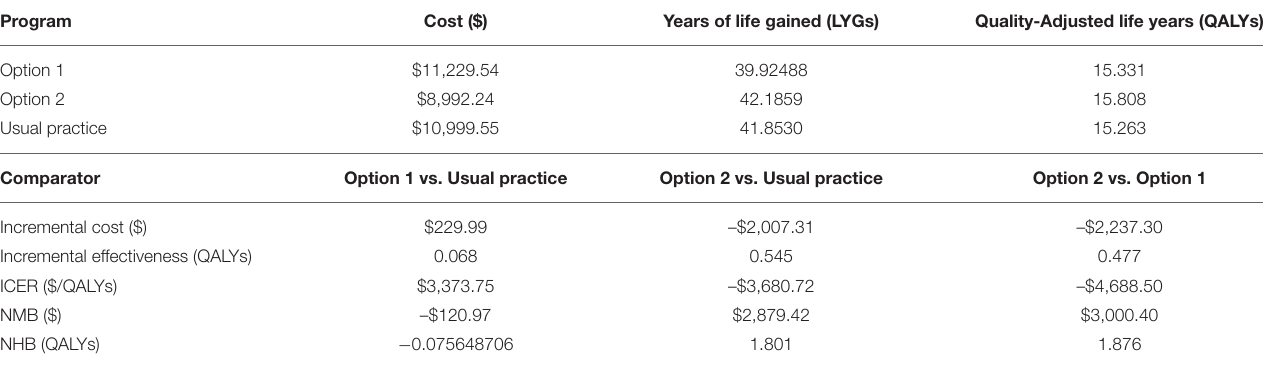
TABLE 8 | Basic results of the costs and benefits of different interventions.